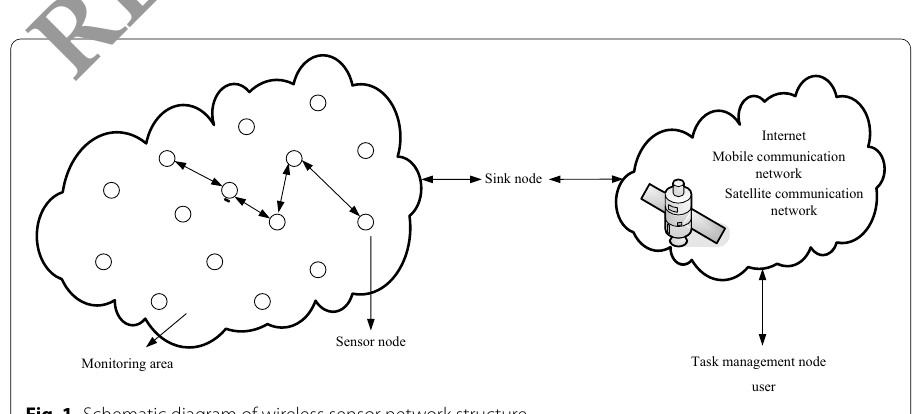
Fig. 1 Schematic diagram of wireless sensor network